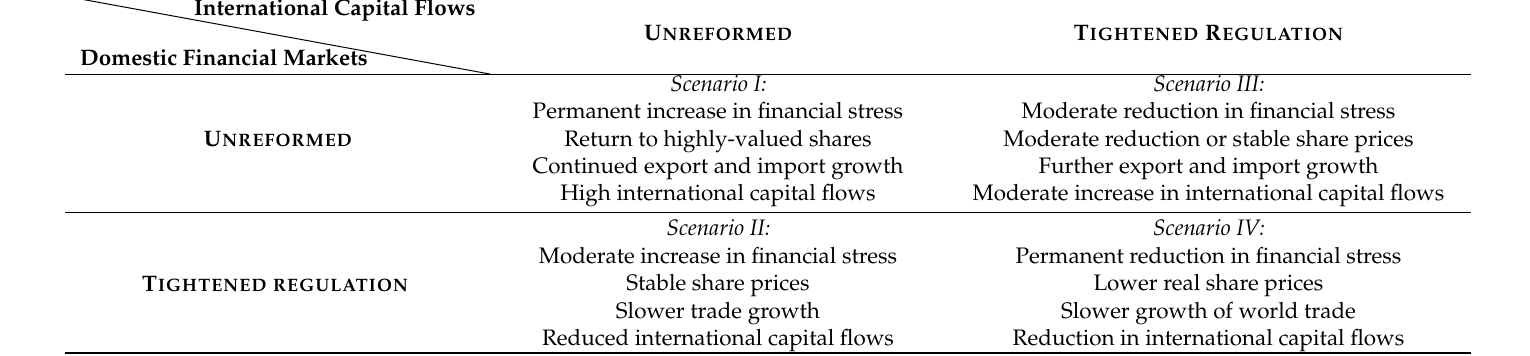
Table 7. Exit scenarios from the crisis: assumptions about macroeconomic implications.